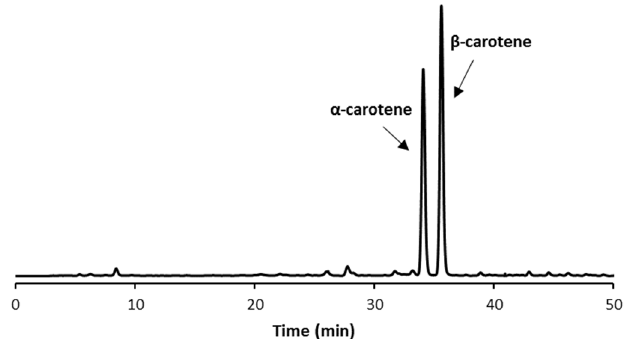
Figure 2. Chromatogram of the HPLC-DAD analysis of pumpkin pulp UAE extract.